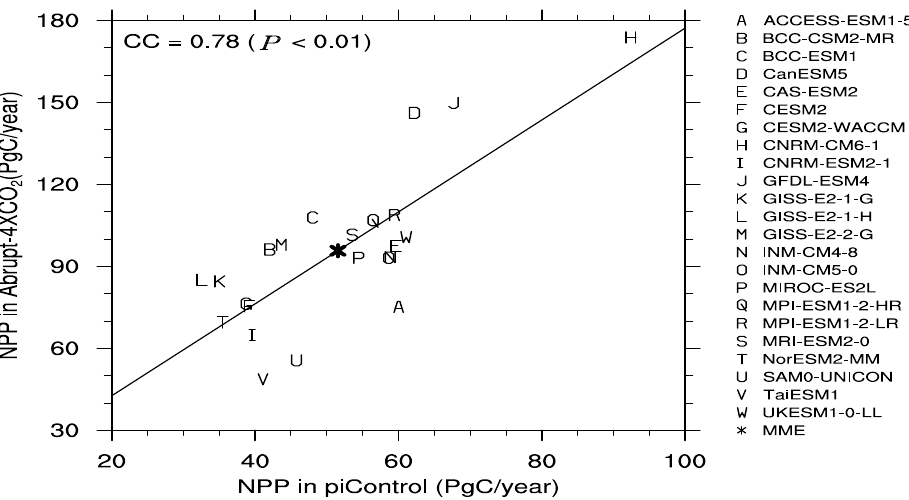
Figure 10. Scatter plot of annual total NPP (PgC year − 1 ) in pre-industrial and abrupt-4 × CO 2 simulations for the 23 models. The line represents their linear regression